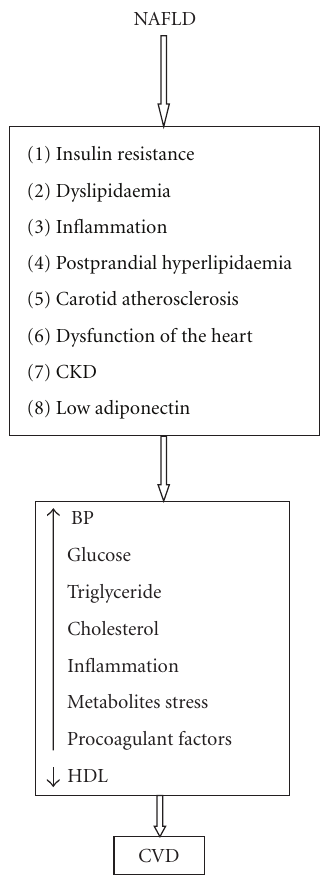
Figure 1: It shows possible potential mechanism of the association of NAFLD with